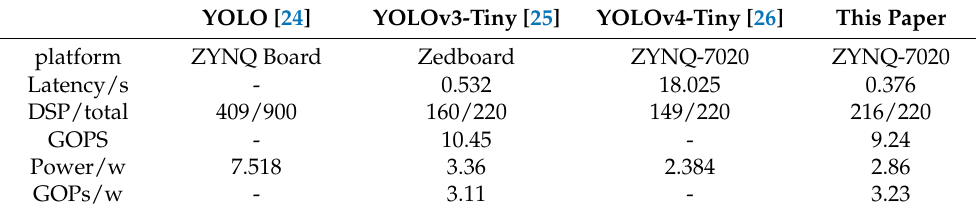
Table 4. Performance comparison between this paper and FPGA implementation of other YOLO series